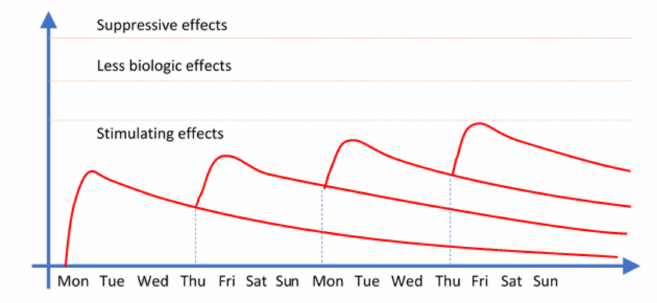
Figure 3. Lasertherapy—biological effects integration (modified from